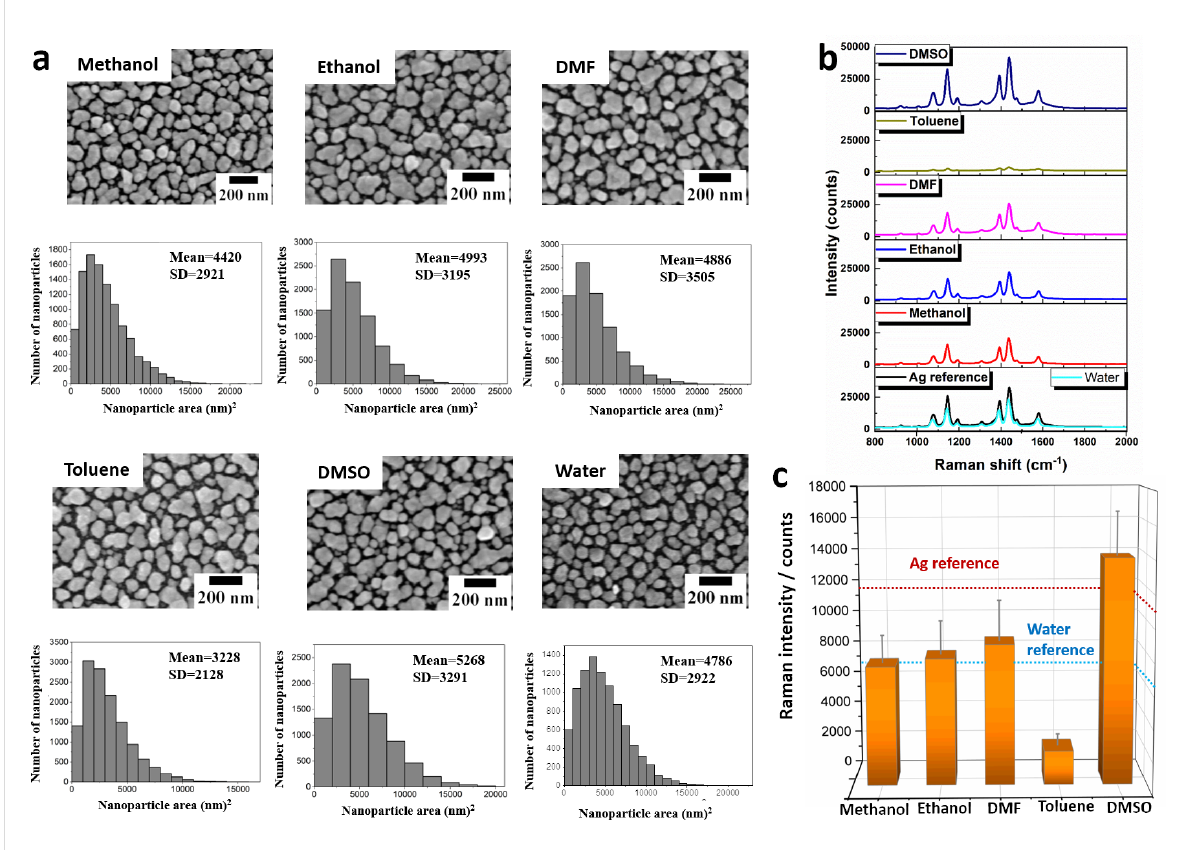
Figure 3: Stability tests of microwave-fabricated SERS substrates for different organic solvents. (a) Morphology of the SERS substrates and corre- sponding particle size distributions of the SERS substrates after 1 h of immersion into methanol, ethanol, DMF, toluene, and DMSO. The projected areas of the nanoparticles were determined by automated analysis and are summarized in the histograms. Each batch synthesis consisted of three substrates. A total of six substrates from two batches were examined by randomly selecting eight different areas measured on each substrate to eval- uate the reproducibility from batch to batch. (b) SERS spectra obtained on the individual SERS substrates of a monolayer of 4-ATP self-assembled on the treated substrates. (c) Error analysis of the 1078 cm − 1 marker peak which is only influenced by the electromagnetic field enhancement mecha- nism [29]. The red dotted line marks the Raman intensity level obtained for the non-treated Ag reference and the blue dotted lines mark the Raman in- tensity level of the water-treated